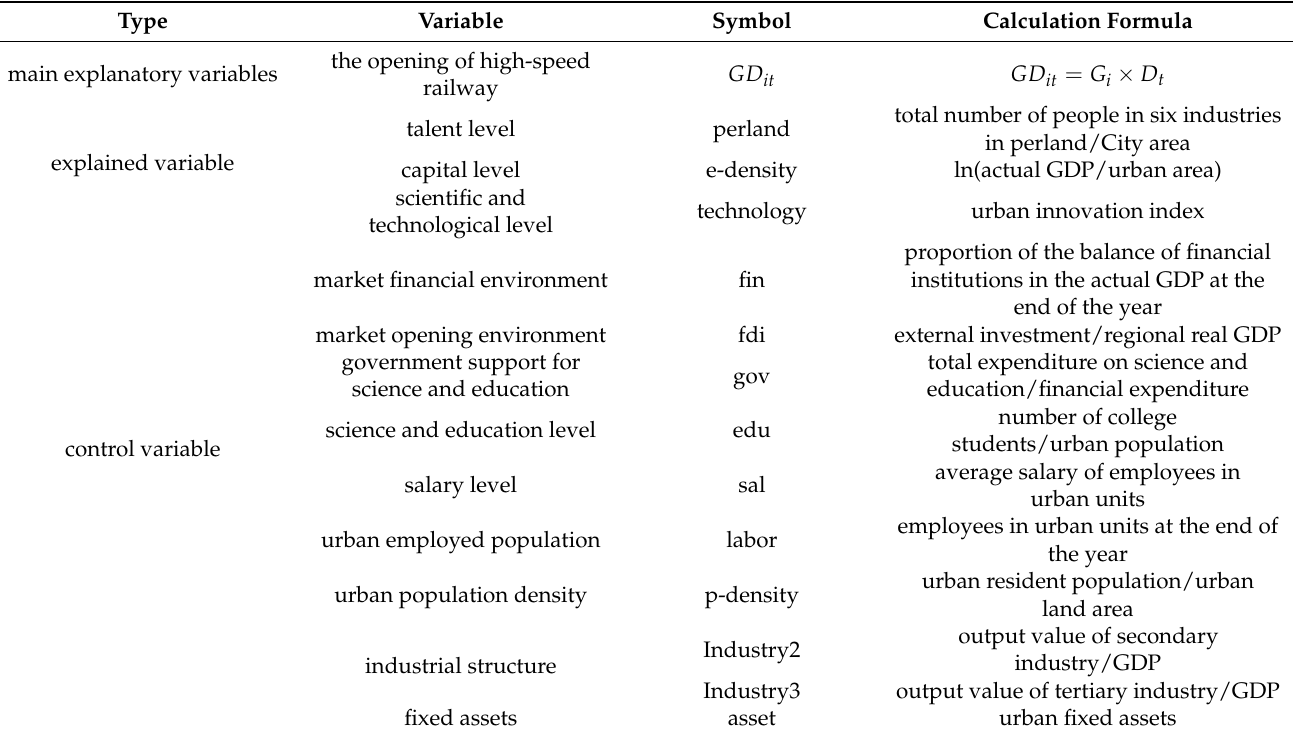
Table 1. Model variables, calculation methods and